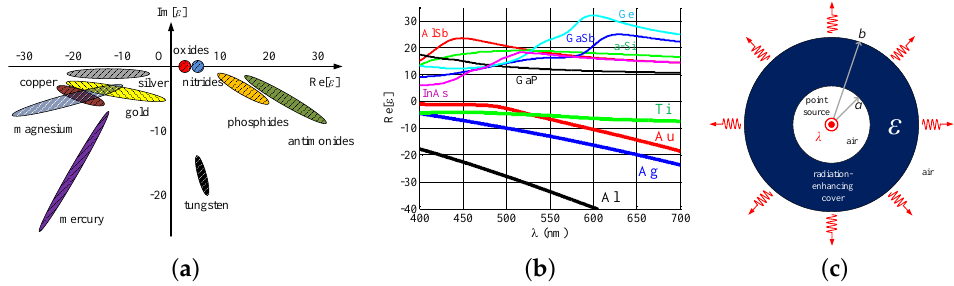
Figure 2. ( a ) Approximate loci of the complex permittivities of basic metals and chemical compounds for various frequencies of visible light (reproduced with permission from [7]); ( b ) exact dispersion of the real part of permittivities across the visible spectrum of the used materials; ( c ) physical configuration of the considered radiation-enhancing